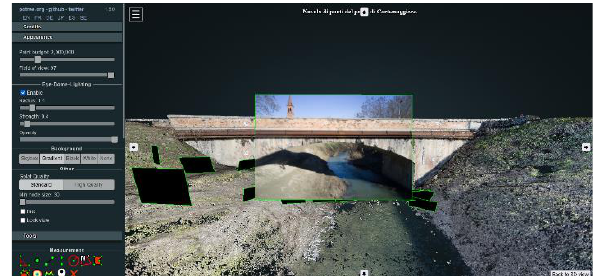
Figure 13. BMS-embeddable web interface developed with